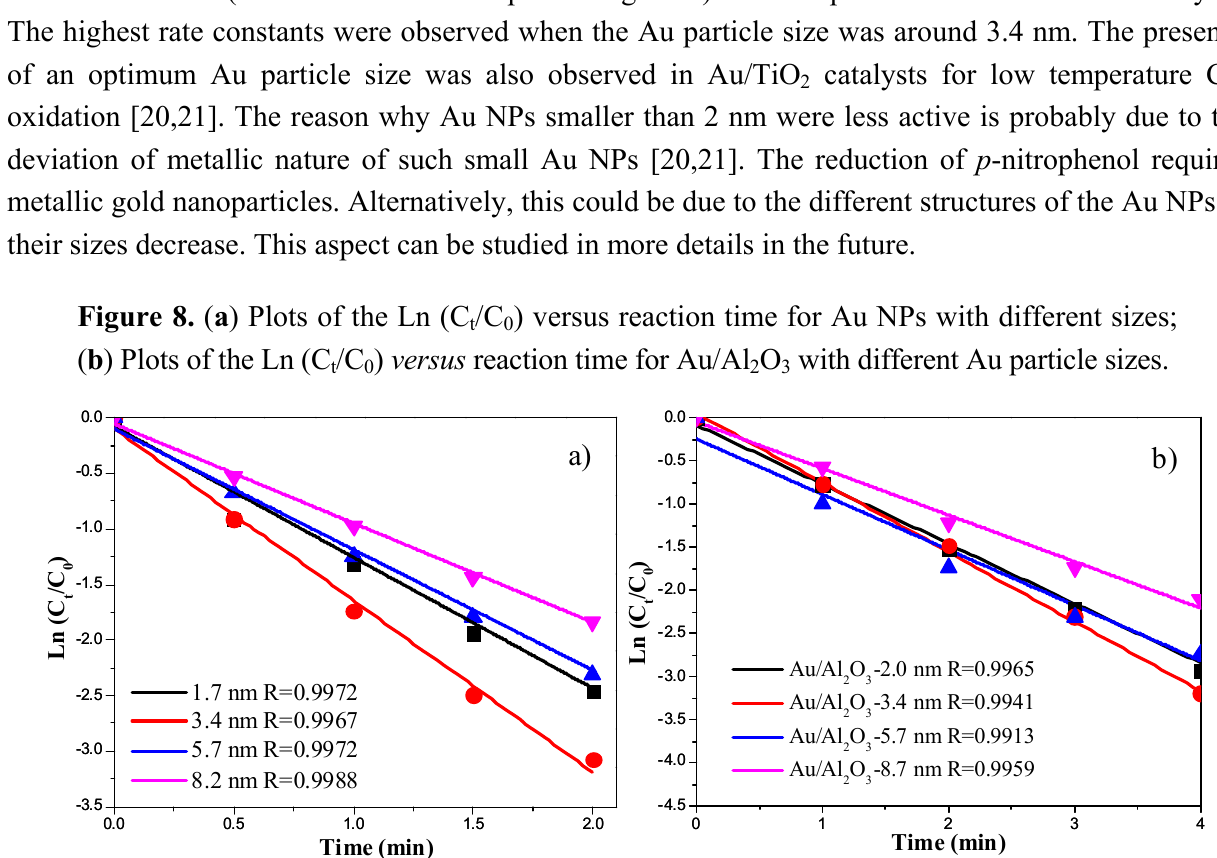
Figure 8. ( a ) Plots of the Ln (C ( b ) Plots of the Ln (C